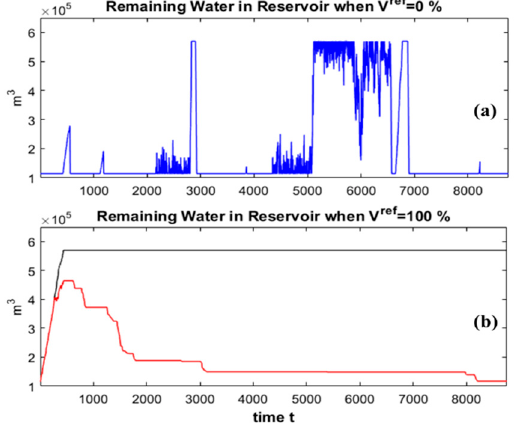
Figure 12. Remaining Water Results for Two Cases.